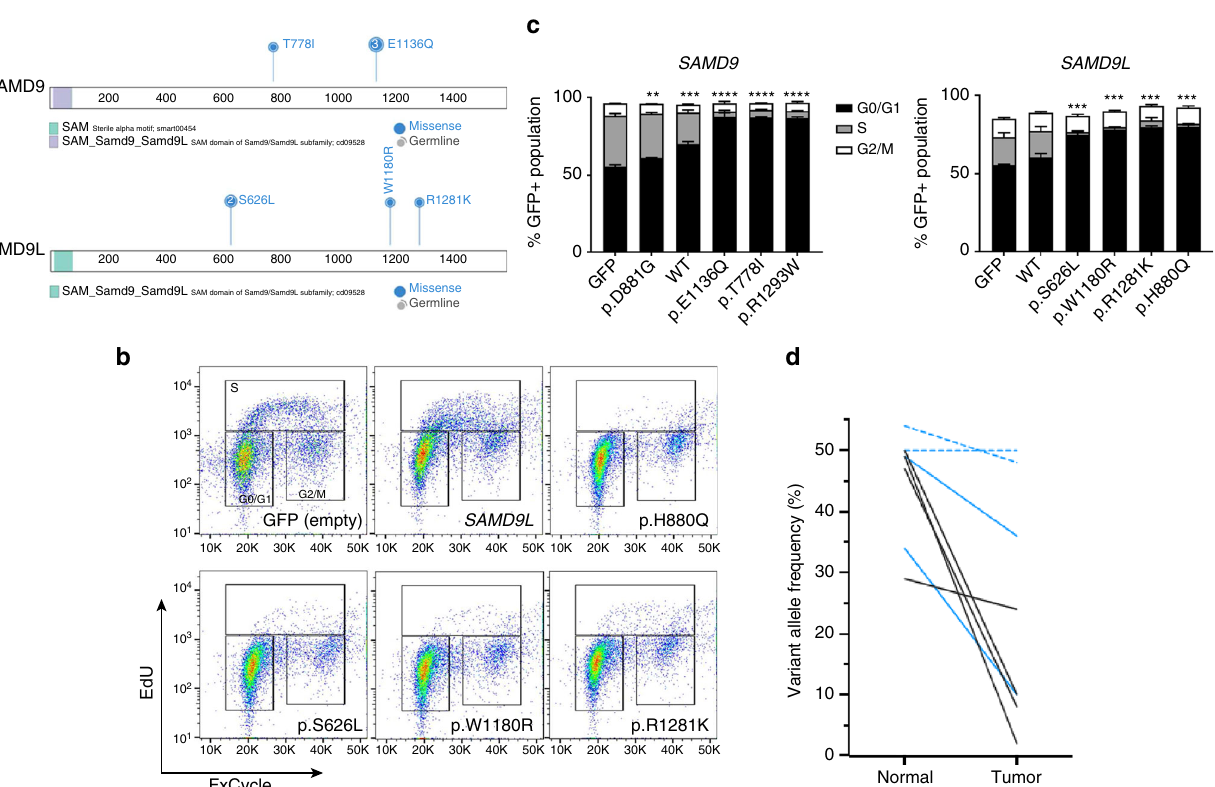
Fig. 4 Gain-of-function mutations in SAMD9 and SAMD9L decrease cell proliferation and inhibit cycle progression. a Schematic showing the protein structure of SAMD9 and SAMD9L . b Flow cytometry plots (FxCycle-total DNA content vs. EdU incorporation) showing the cell cycle inhibiting effects of gain-of-function SAMD9L mutations. SAMD9L p.H880Q (positive control) is a gain-of-function mutation previously reported in Ataxia-Pancytopenia syndrome 21 . c EdU incorporation assay showing that gain-of-function SAMD9/SAMD9L mutations inhibit cells from progressing through the cell cycle as depicted by the relative absence of cells in S-phase. SAMD9 p.R1293W (positive control) is a previously reported gain-of-function mutation in MIRAGE syndrome 19 . SAMD9 p.D881G is a common SNP that is not predicted to be pathogenic. ** : p < 0.01, *** : p < 0.001, **** : p < 0.0001 (student ’ s t -test). Error bars indicate standard deviation. Data in B & C are representative of 2 – 3 experiments completed in triplicate. d VAF plot, obtained from targeted deep sequencing, showing the preferential loss (decrease in VAF) of the SAMD9/SAMD9L mutations in the tumor population. Black lines: SAMD9 ; Blue lines: SAMD9L ; dashed lines indicate cases where a subclonal (3/20 metaphases) del(7) was detected only by conventional